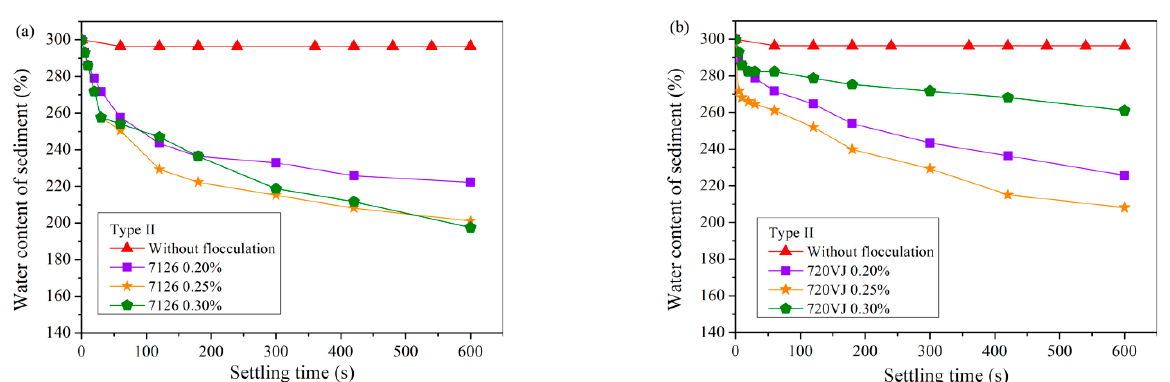
Figure 6. Sedimentation results of slurry (Type Ⅱ ) after pretreatment with APAM. ( a ) 7126. ( b ) 720VJ.